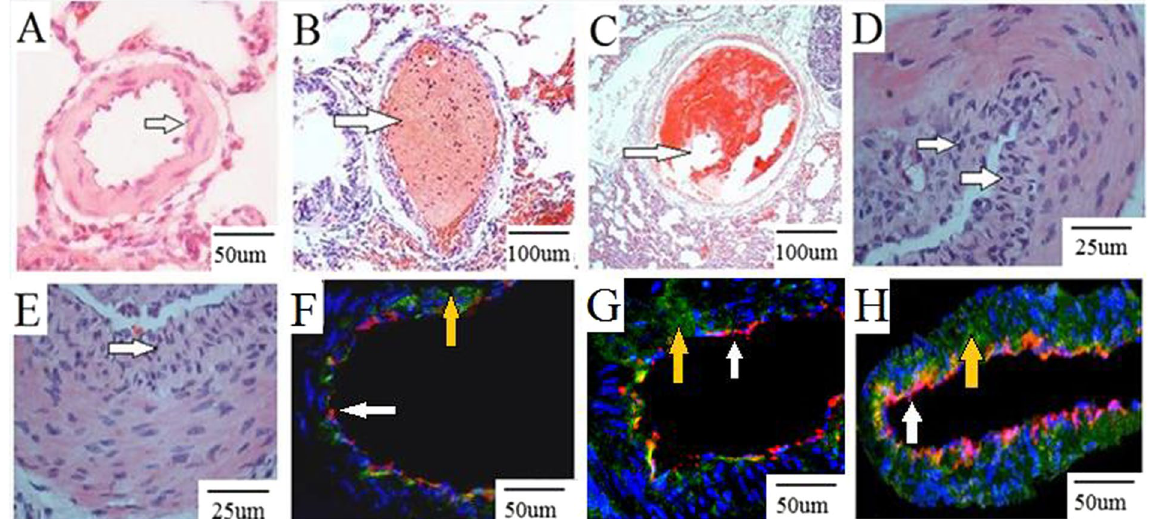
Figure 2. Pathological changes in the pulmonary artery in the rat CTEPH model. Note: No significant changes in the pulmonary artery were detected in the sham group ( A ). One hour after injection, pathological changes included connective tissue organization surrounding the reddish-brown thrombus ( B ); the thrombus ( C ) was smllar in the 1-week experimental subgroup. At 4-weeks, increased growth of pulmonary artery endothelial layer were detected ( D,E ). Vimentin and FVIII factor in sham group ( F ), 1-week ( G ) and 2-week ( H ) experimental subgroup. Red light: FVIII factor (white arrows), green light: vimentin (yellow arrows), blue light: nuclear.